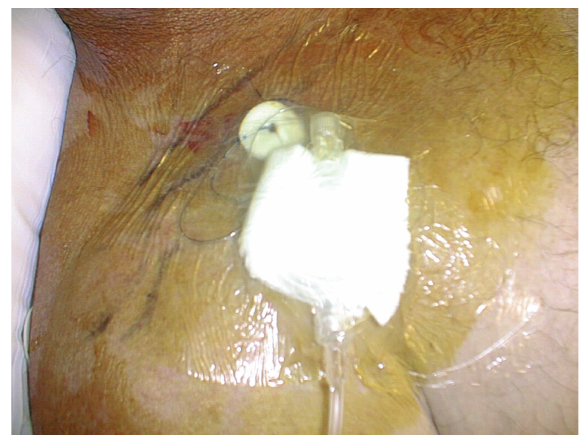
Figure 3: Elastomeric pump for a wound